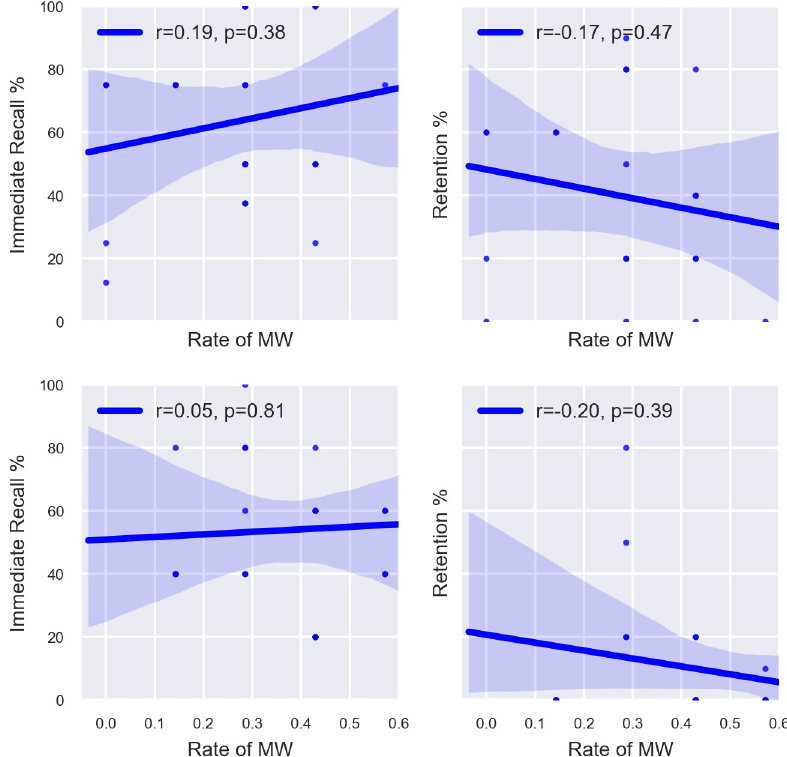
Fig 2. Top Left: MW rate versus immediate recall during Lecture 1. Top Right: MW rate versus retention during Lecture 1. Bottom Left: MW rate versus immediate recall during Lecture 2. Bottom Right: MW rate versus retention during Lecture